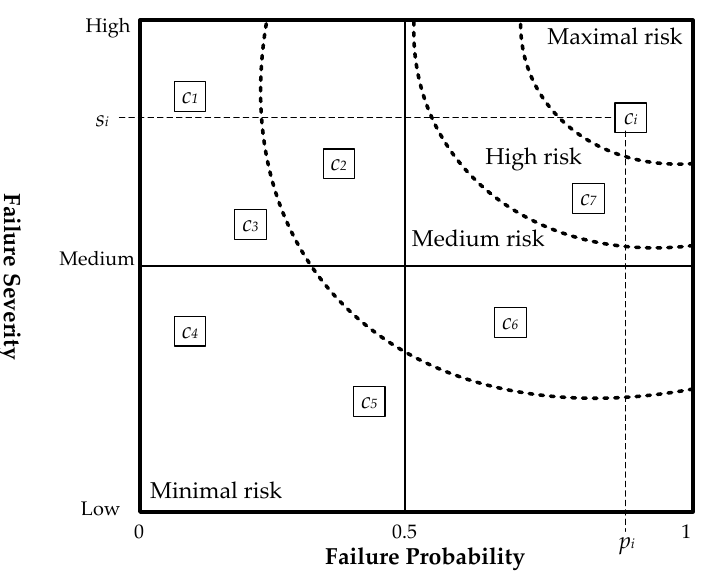
Figure 3. Relation between failure severity and probability.